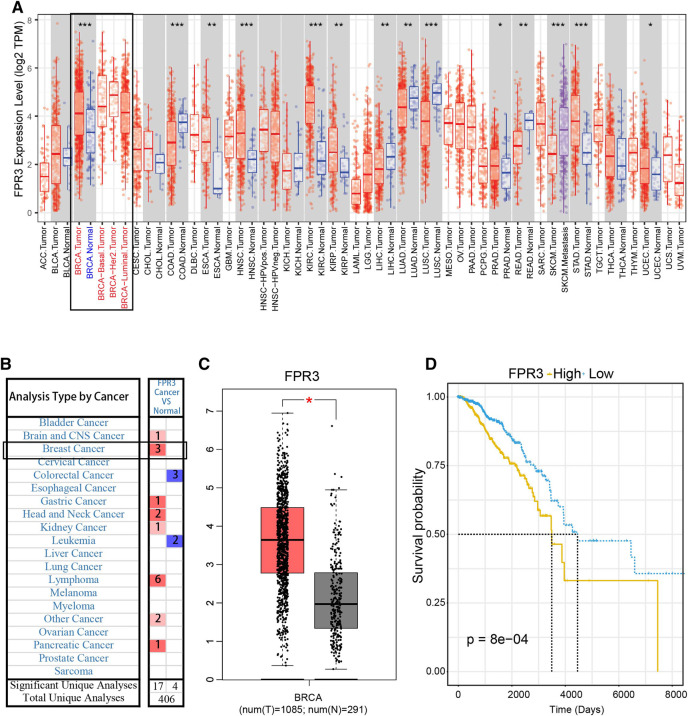
FPR3 expression in breast cancer (A) TIMER showed the expression level of FPR3 in pan-cancer, and the expression of FPR3 in total breast cancer cases and different subtypes was higher than that in adjacent normal tissues (B) The transcription levels of FPR3 in different types of cancers (Oncomine database). The graph shows the number of data sets in which the mRNA expression of the target gene was significantly up-regulated (red) or down-regulated (blue). The threshold was defined by the following parameters: P < 1E-4 and FC > 2 (C) To further examine the expression level of FPR3 between breast cancer and normal tissues, FPR3 was examined using the GEPIA web-based tool (*, p < 0.05). Red color indicates tumor tissue and gray color indicates normal tissues (D) Kaplan-Meier survival curves were generated for FPR3. The higher the expression of FPR3 (yellow line), the shorter the survival period. p value in the log-rank test. OS, overall survival.